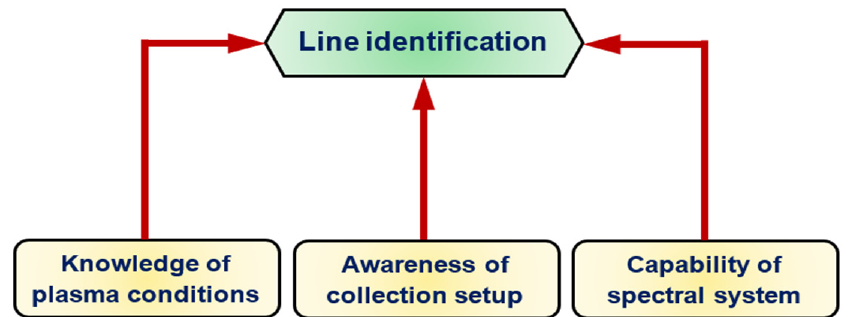
Figure 5. Key factors to be considered for the line identification in a complex spectrum.